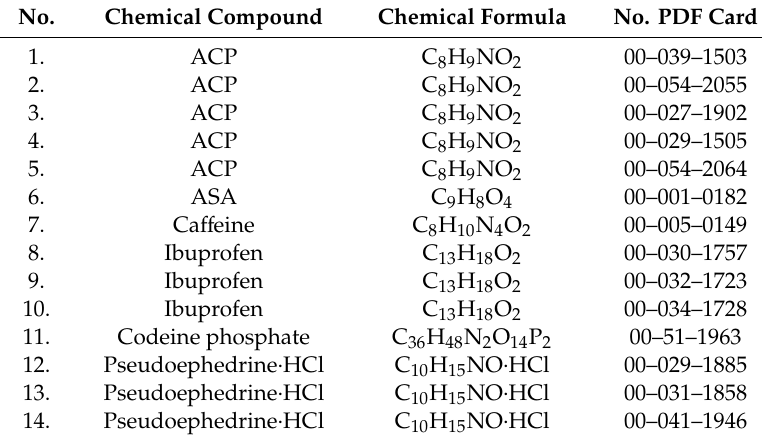
Table 11. List of used ICDD PDF2 (Release 2008)